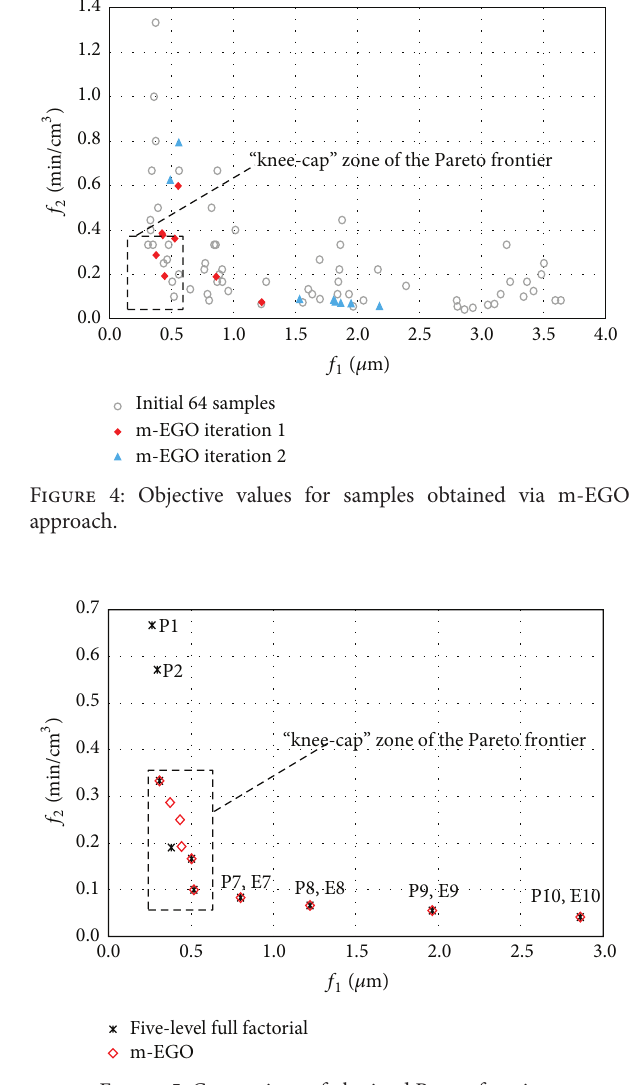
markings horizontal spacing. Also, with higher depth of cuts, the vertical spacing between peaks and troughs of the surface irregularities was larger. Thus, higher feed rates and depth of cuts generally lead to higher surface roughness. However, higher feed rates and depth of cut are favorable in terms of increasing material removal rate. Thus, there is good motivation for finding the right combination of settings of between surface quality and machining time. Search for this good compromise may be done via “dense sampling” (such as the five-level full-factorial design of experiments) or through optimization techniques (such as m-EGO).